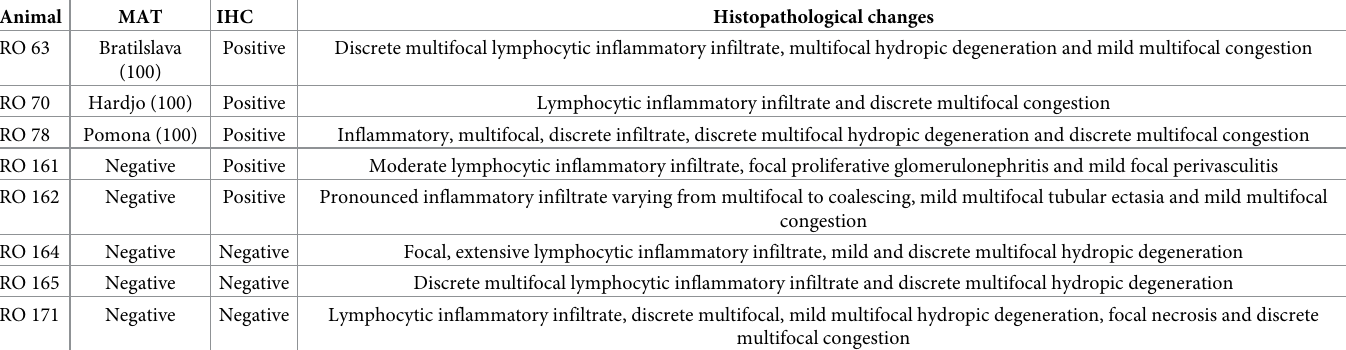
Table 3. Description of MAT results, IHC and histopathological changes in sheep kidneys positive in PCR for pathogenic leptospires. Animal MAT